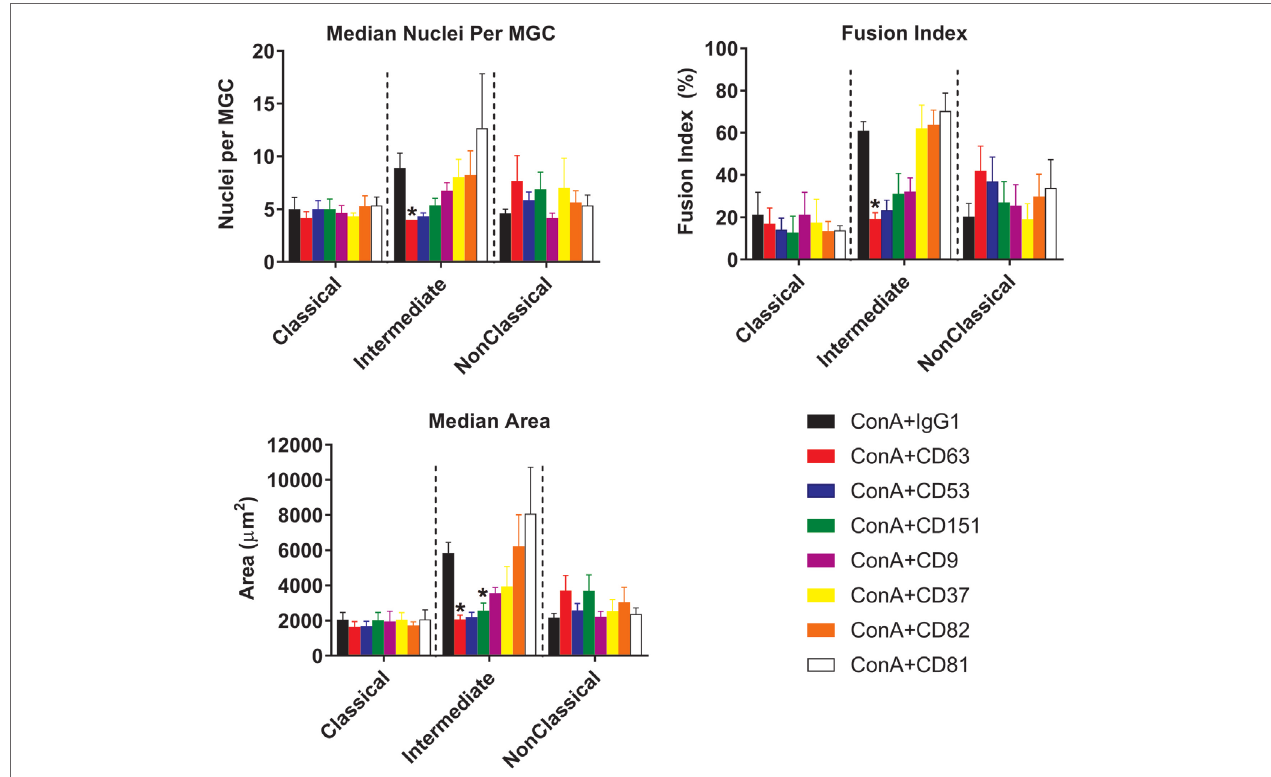
FigUre 8 | Anti­tetraspanin antibodies inhibit fusion rate and size of giant cells produced by intermediate monocyte subset. Purified monocyte subsets were cultured in media containing (ConA) and either an anti­tetraspanin antibody or IgG1 control at 10 µg ml − 1 for 72 h. Bars represent means ± SEM, of 3–8 separate experiments. Significance was tested with a Kruskal–Wallis test and a Dunn’s multiple comparisons test comparing the anti­tetraspanin antibody means against the IgG1 control within each